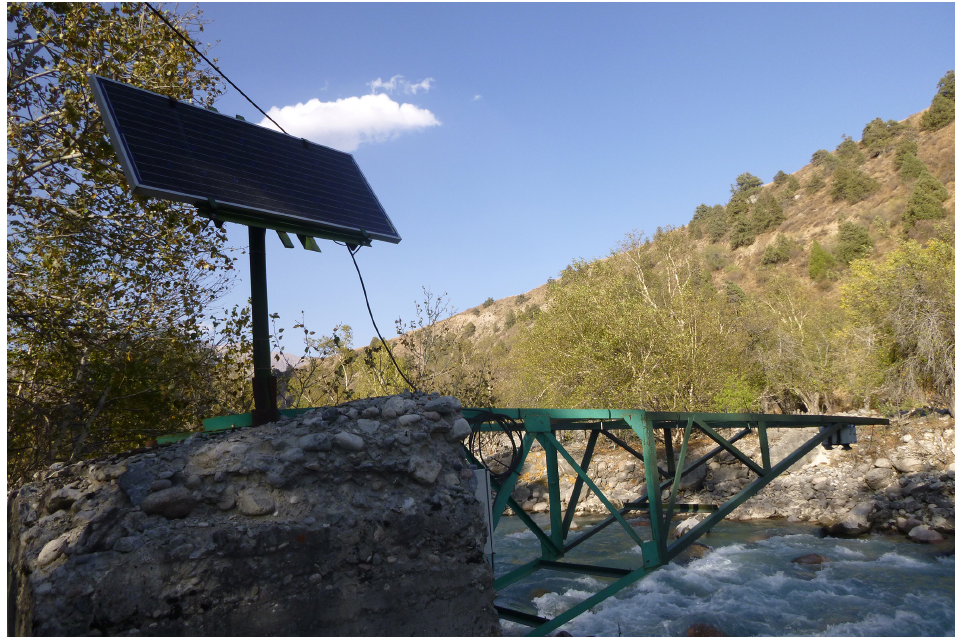
Figure 5. River discharge system at station MTAL with a solar panel and the boom for the sensor. Table 2. Station list with their start of operation dates and the installed sensors systems. While the column “Meteo. sensors” refers to various individual sensors, the “Weather sensor” column refers to the compact weather transmitter (station type two). Station Partner Name Meteo. sensors Weather